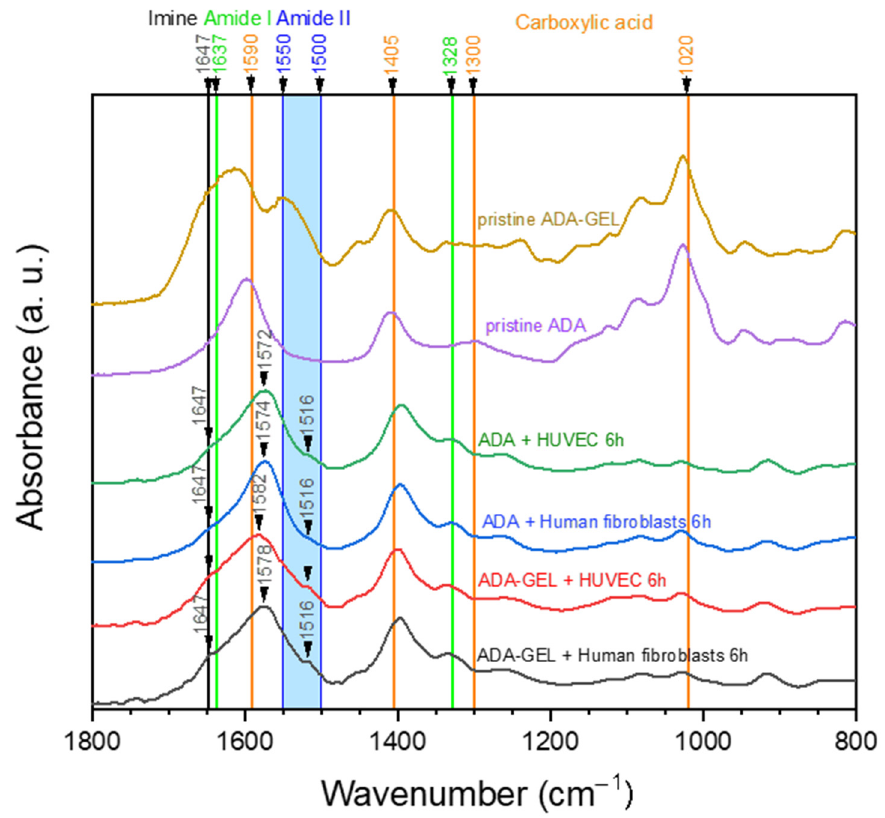
Figure 9. FTIR spectra of hydrogel samples from cell culture experiments after 6 h of incubation in comparison to pristine ADA and ADA-GEL. Cells were removed from the hydrogels prior to measurements, and “+ HUVEC” indicates samples that were obtained from cell culture with primary ECs. The characteristic peaks are discussed in the text.